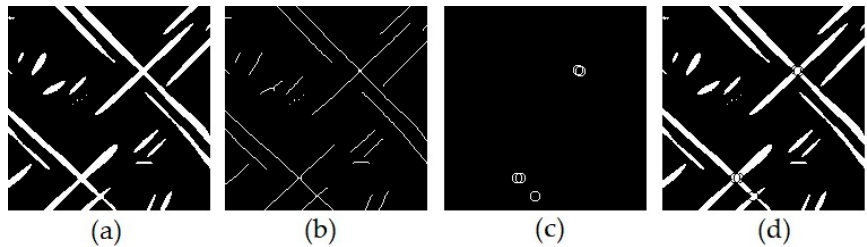
Figure 8. ( a ) The original binary image, ( b ) the objects’ skeletons, ( c ) conversion of the line intersection points to circles and ( d ) the disjoint line segments.